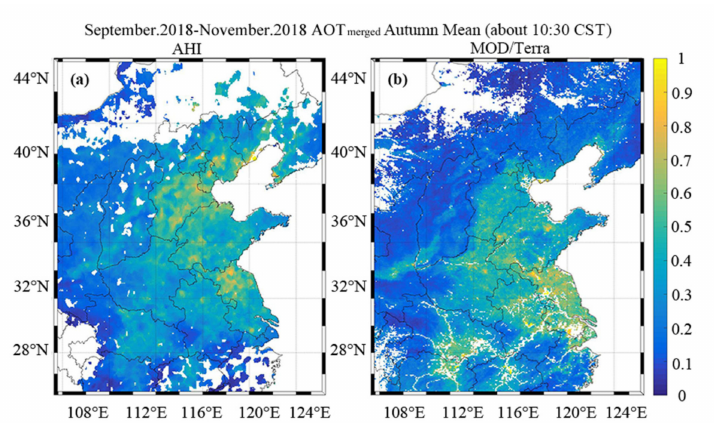
Figure 12. The AOT merged 5km summer mean spatial distribution of three versions at about 10:30 CST. ( a ) version 030; ( b ) MODIS /